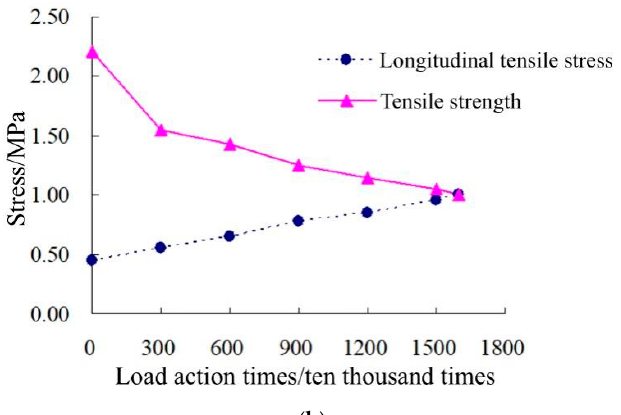
Figure 21. Longitudinal mechanical characteristics of base plate under fatigue load (working condi- tion 2). ( a ) Cross-sectional stress development diagram at the maximum longitudinal tensile stress of the base plate; ( b ) number of cracks at the maximum longitudinal tensile stress of the base plate. (3) Working condition 3: load acted on the top of the sleeper at the end of the slab